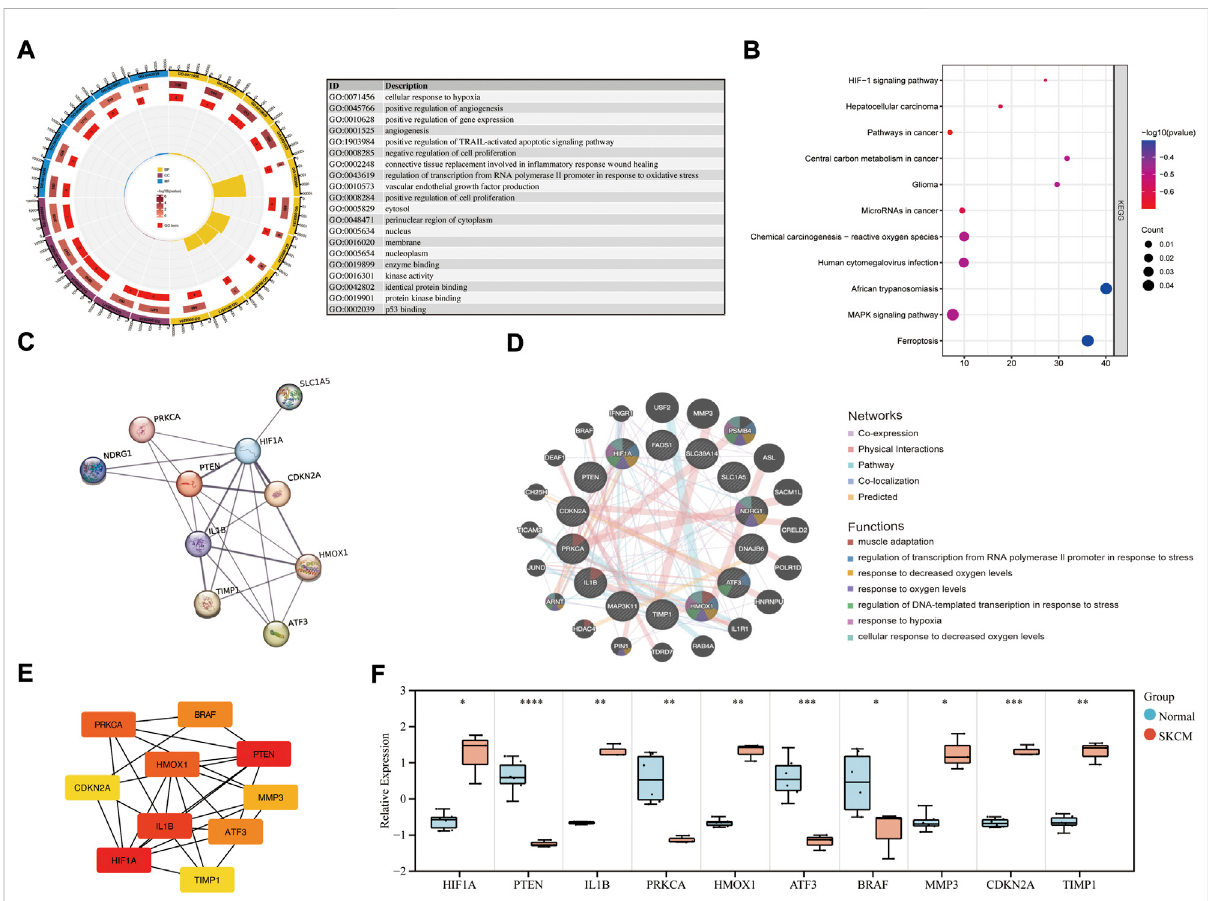
FIGURE 2 Enrichment analysis of common DEGs and PPI network construction. (A) GO enrichment analysis of common DEGs. (B) KEGG enrichment analysis of common DEGs. (C) PPI network of common DEGs was constructed by STRING. (D) Co-expression PPI networks of common DEGs were constructed by GeneMANIA. (E) The top 10 hub genes in the co-expression network were obtained and visualized with Cytoscape. (F) The mRNA expression level in melanoma cell lines and health controls.